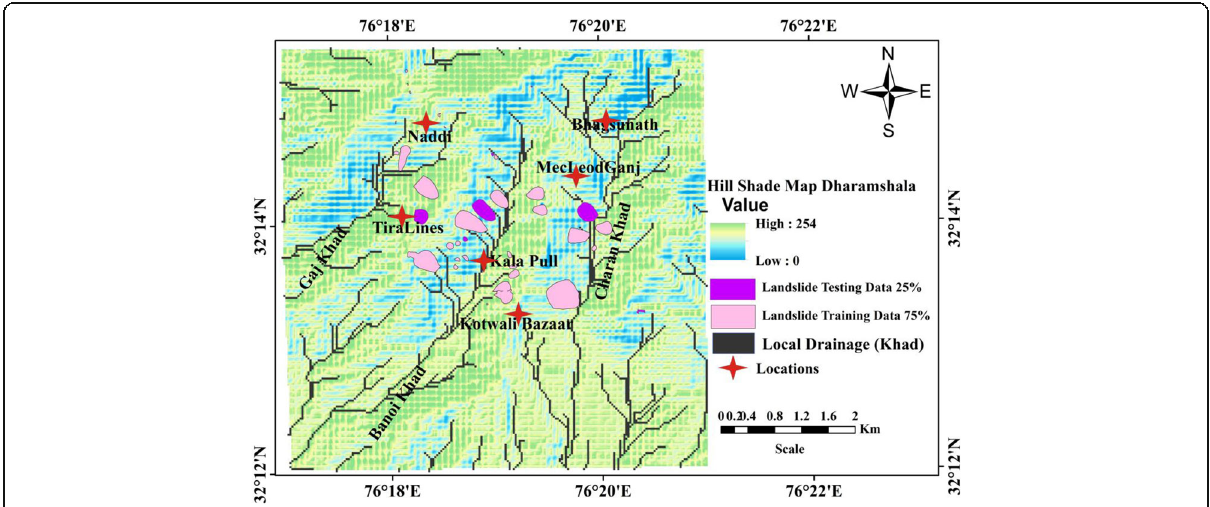
Fig. 3 Landslide Inventory shown in the hill shade map of the study area prepared using the DEM data